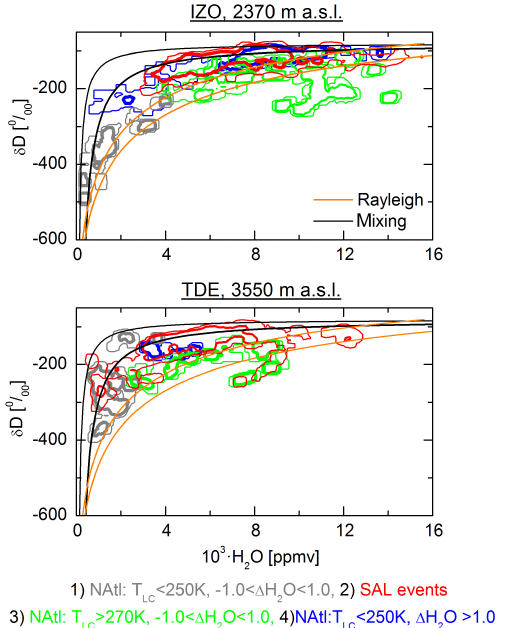
Figure 10. H 2 O- δ D distributions as obtained for the four differ- ent moisture pathways that determine the free troposphere mois- ture budget in the surroundings of Tenerife (Left panel for IZO and right panel for TDE). Contour lines indicate the areas of highest data point density. The thin dashed and thick solid lines mark the areas that include 95 and 66% of all data respectively. The differ- ent colour of the contour lines mark the different pathways (1–4) as given in the legend. Rayleigh and mixing curves are plotted as in Figs. 5, 6, 8, and